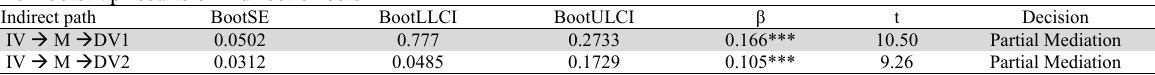
The Bootstrap results of indirect effects Indirect